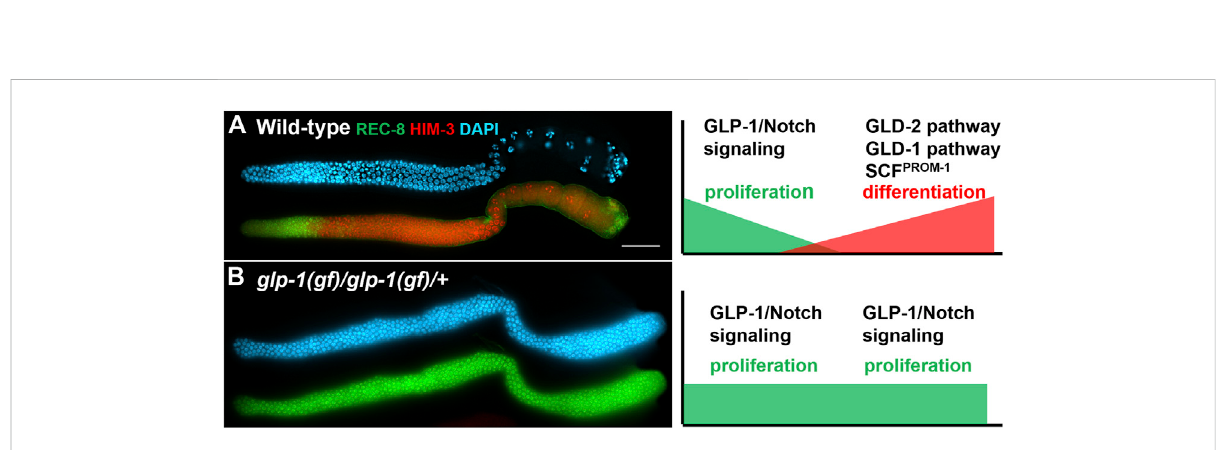
FIGURE 2 Dissected adult hermaphrodite gonad arms stained with a proliferative marker (green: anti-REC-8), a meiotic marker (red: anti-HIM-3), and DAPI to visualize DNA (blue). On the right are models depicting relative levels of GLP-1/Notch signaling and the GLD-1, GLD-2 and SCF PROM − 1 downstream pathways (A) Wild-type adult hermaphrodite (adapted from (Hansen et al., 2004a)). (B) A tumorous germline from glp-1(oz112gf) homozygous hermaphrodite that also carries a wild-type copy of glp-1 on a free duplication (adapted from (Hansen et al., 2004b)). Scale bar: 20